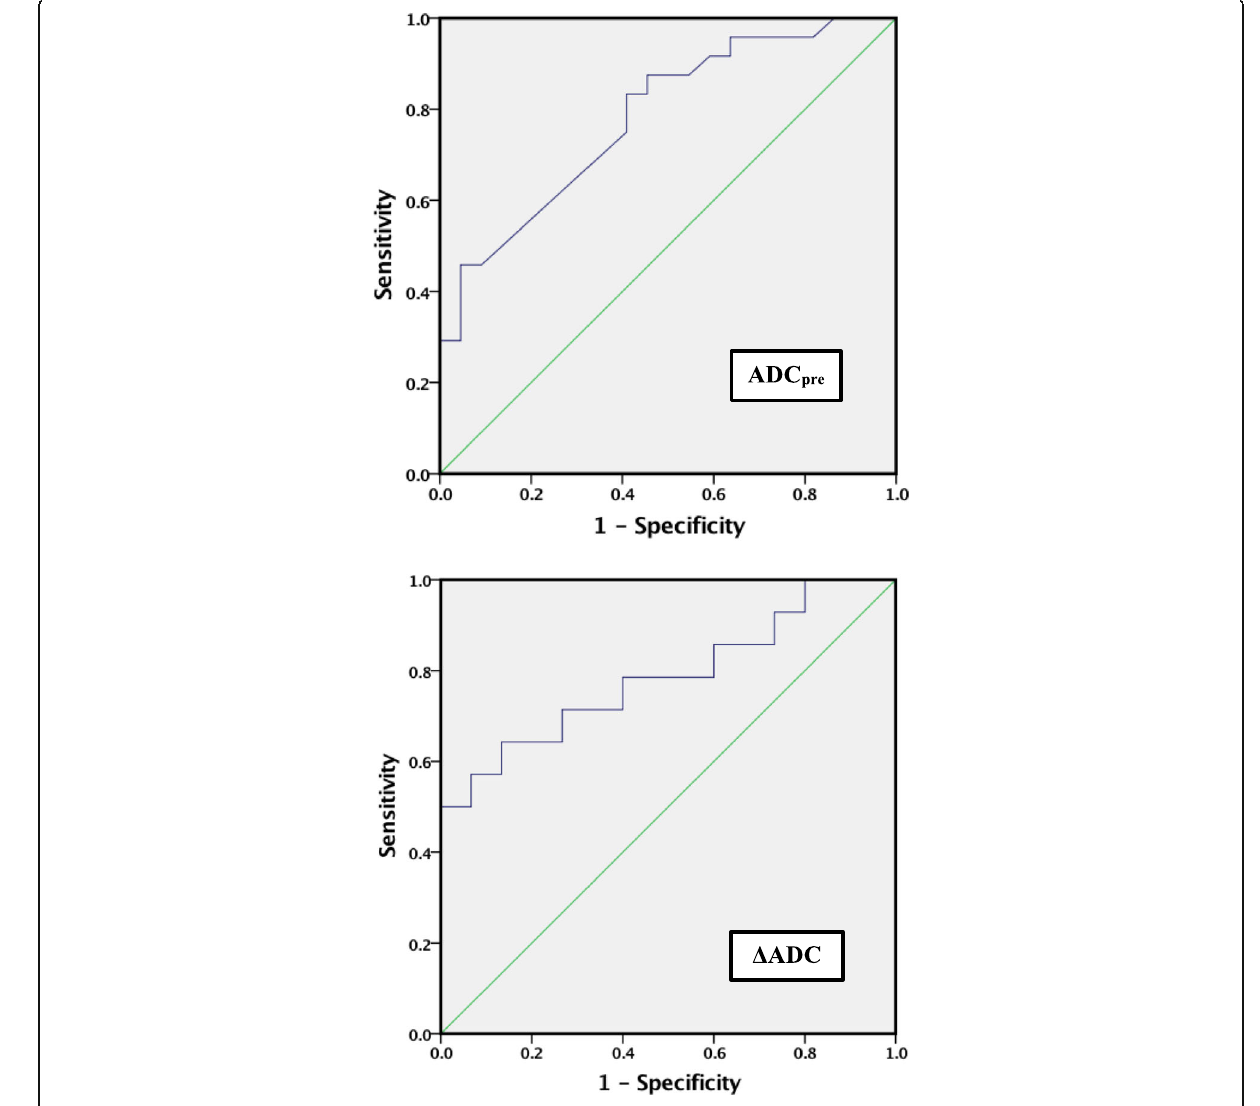
Fig. 7 ROC curve for ADC pre and Δ ADC to predict local failure after CRT